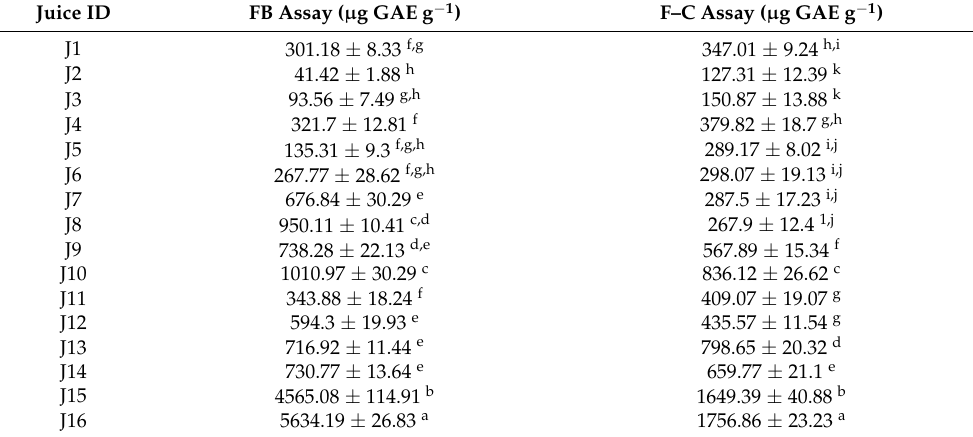
Table 2. Total phenolic content of commercial juice extracts measured by the optimized FB and Folin– Ciocalteu (F–C) assays. Results represented as mg g − 1 ± SE as gallic acid equivalents (GAE). For each juice, means with the same letters indicate no significant differences ( p ≤ 0.05) in the different juices. Juice ID